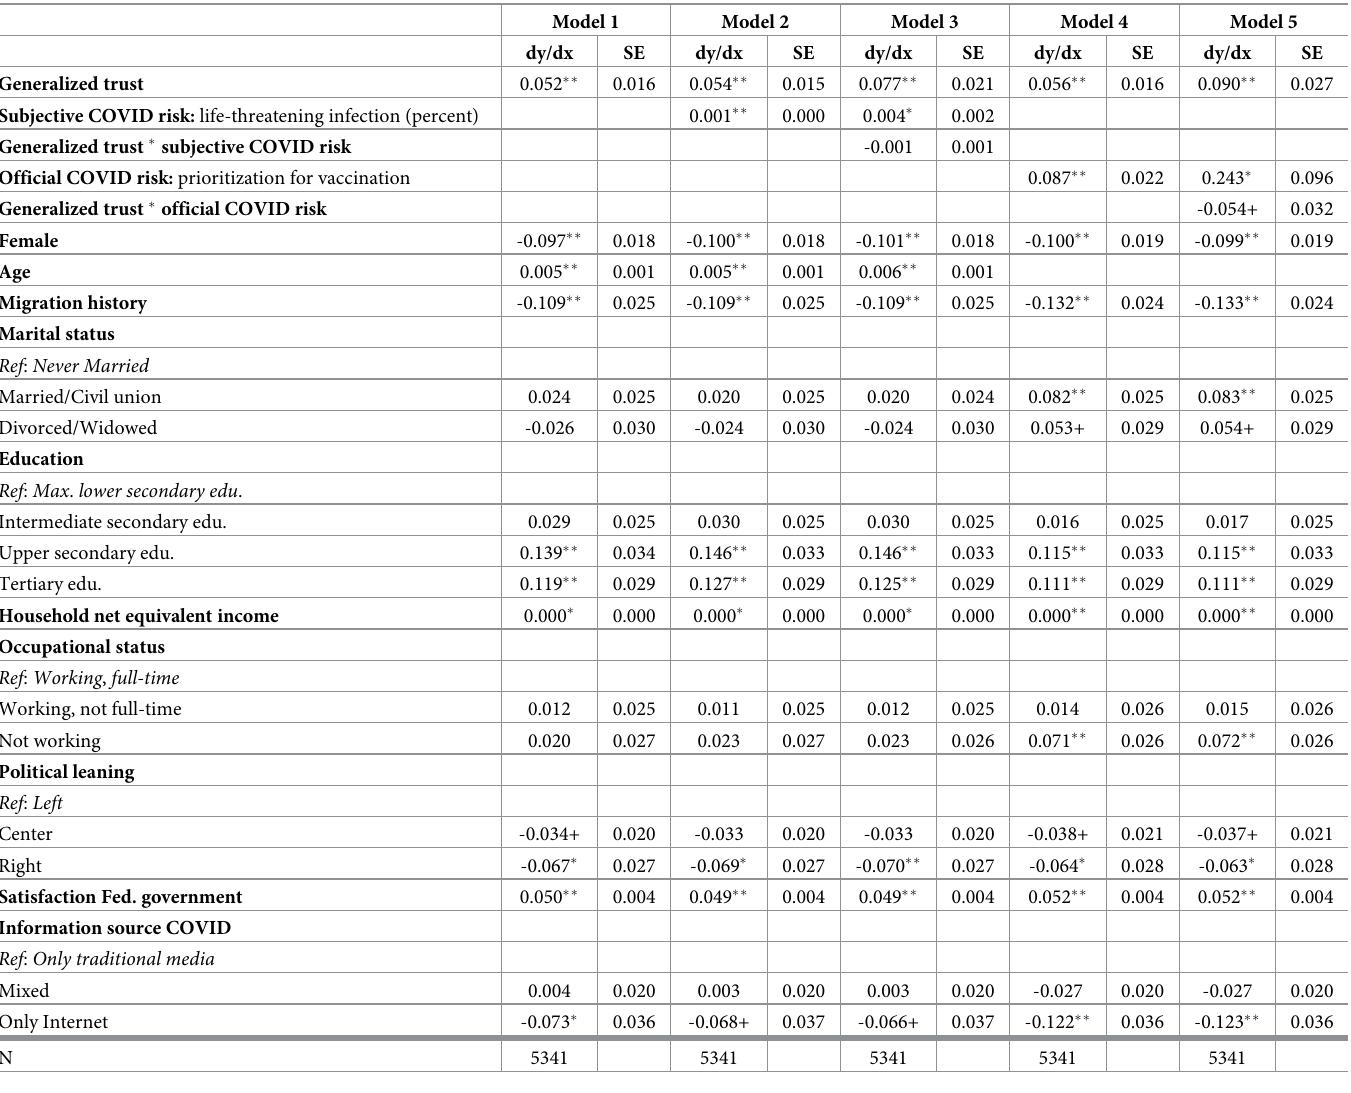
Table 2. Multiple logistic regression—dependent variable: Vaccine